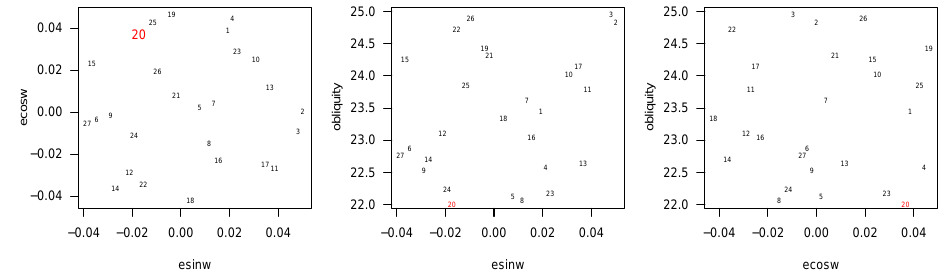
Figure 1. Two-dimensional projections of the experimental design. The experiment marked in red (experiment 20) was discarded from the